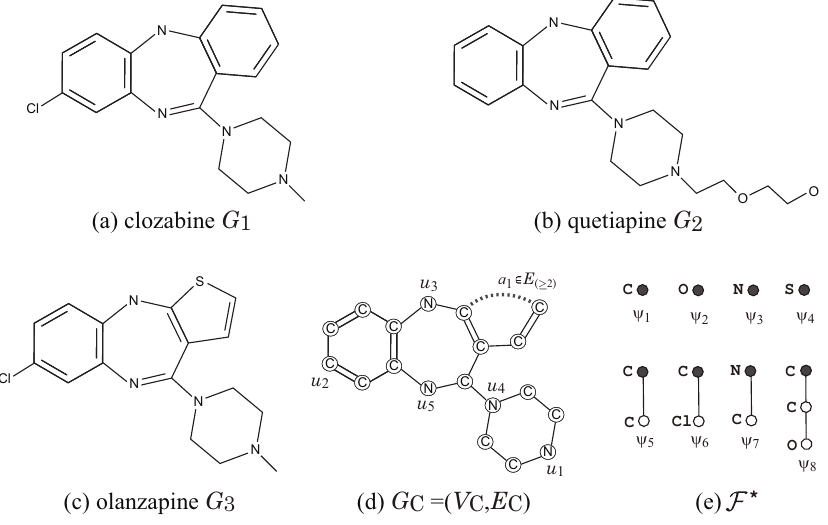
Figure 8. Illustration of a set G ∗ = { G 1 , G 2 , G 3 } of three dibenzodiazepine atypical antipsychotics, a seed graph G C and a set F ∗ = { ψ 1 , ψ 2 , . . . , ψ 8 } of chemical rooted trees for ρ = 2: ( a ) clozabine G 1